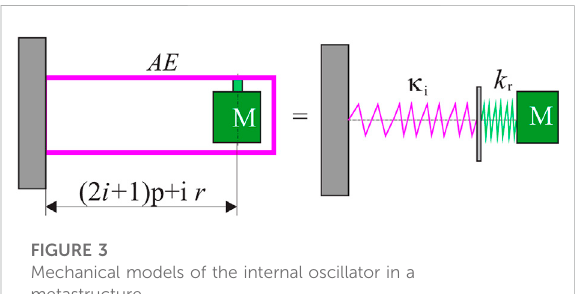
FIGURE 3 Mechanical models of the internal oscillator in a metastructure.